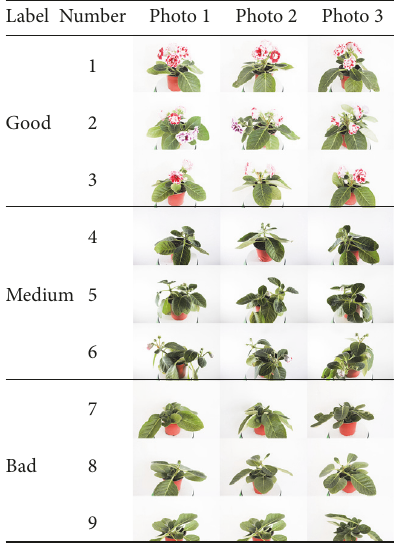
Figure 1: Typical samples of the dataset.